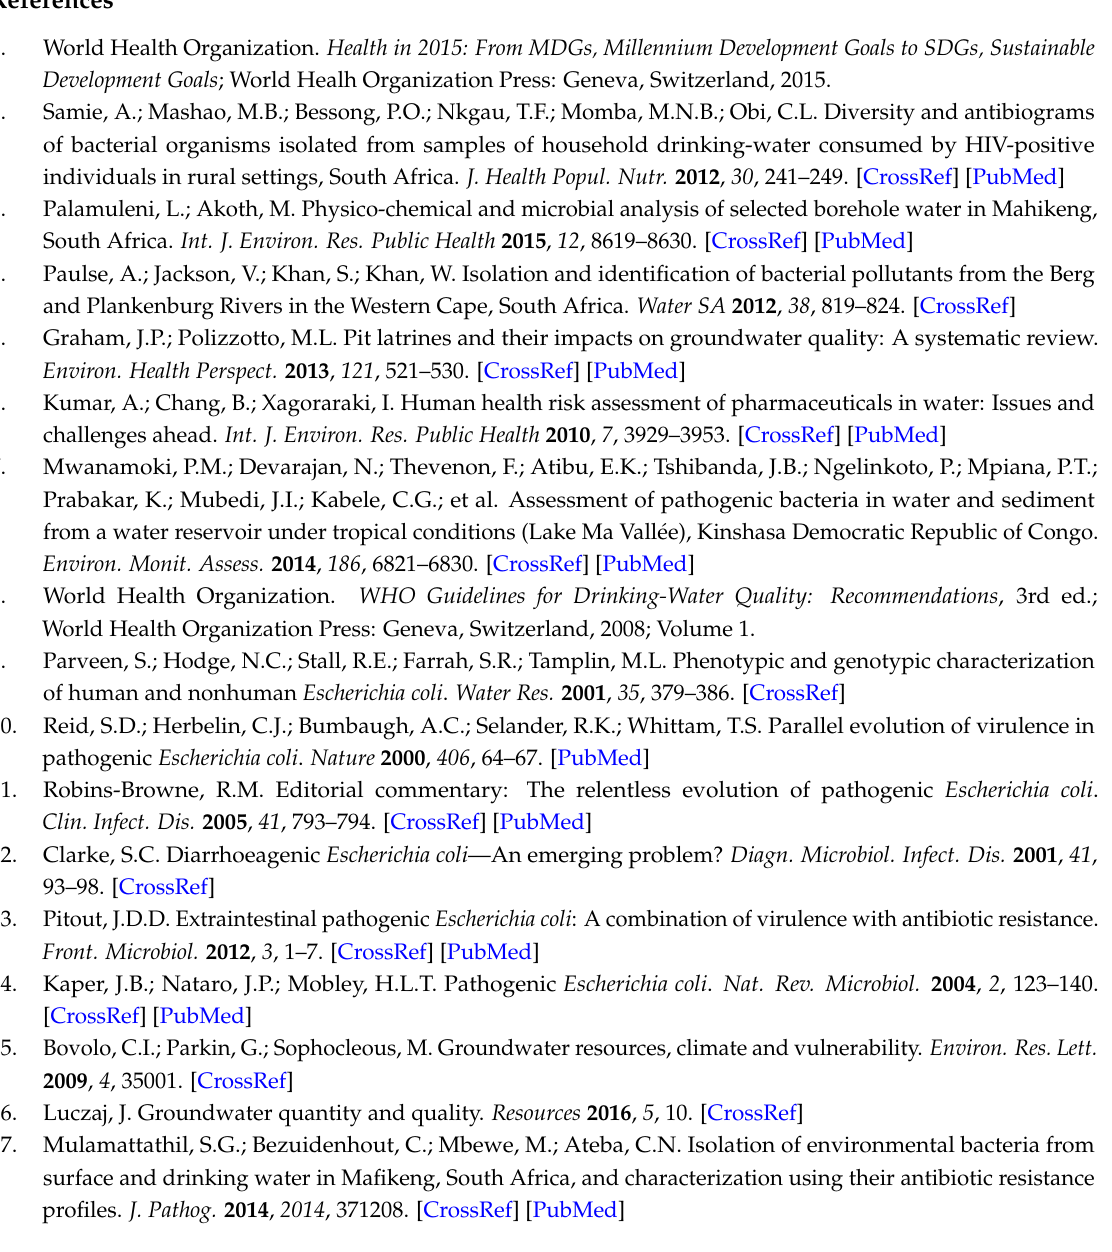
Figure S1: High-resolution melt curves (HRM) for each PCR